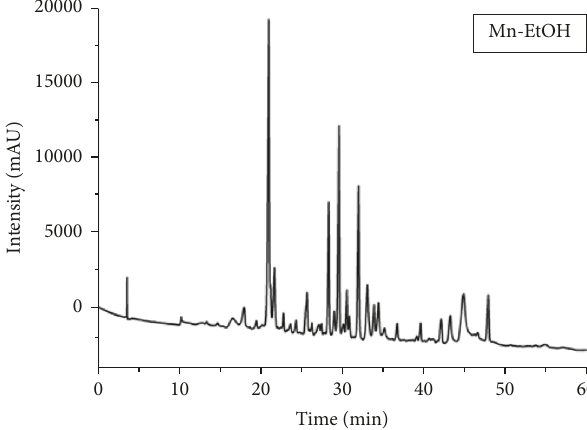
Figure 1: Phenolic compounds profile of the EEMn.